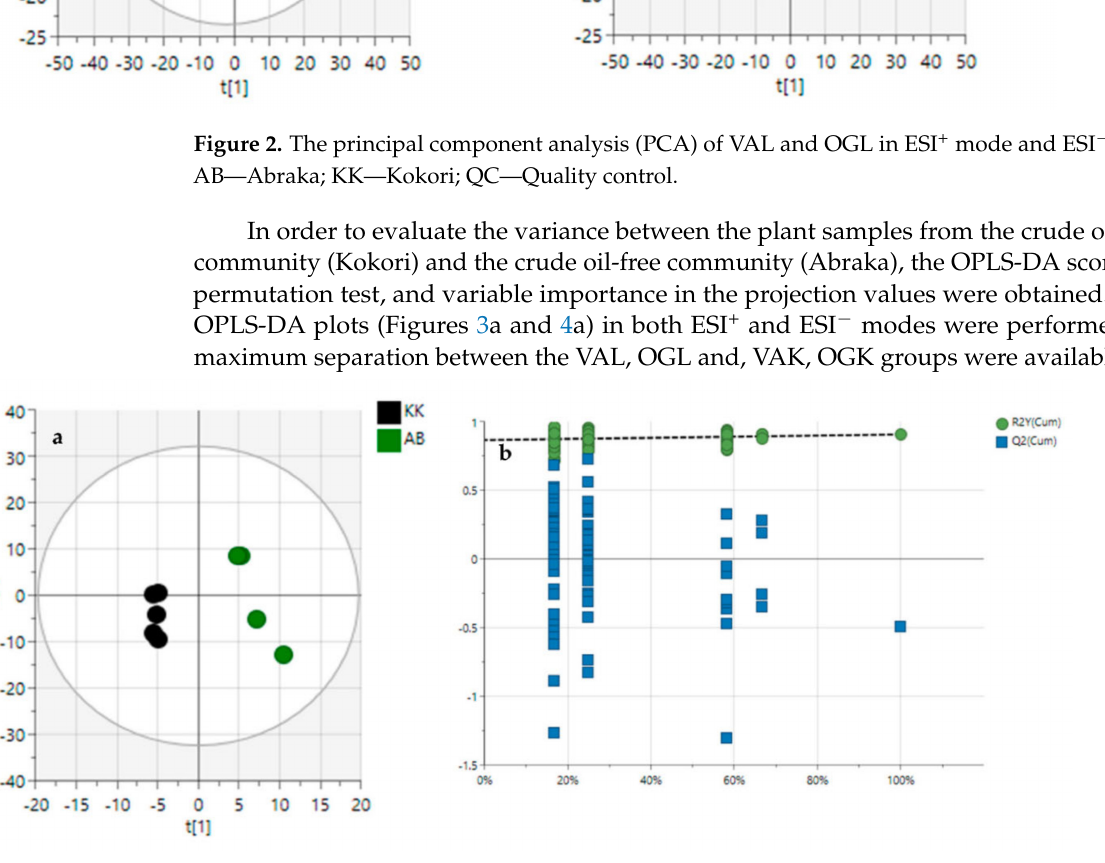
Figure 3. Orthogonal partial least squares discriminant analysis (OPLS-DA) ( a ), permutation tests, ( b ) in ESI + mode. AB—Abraka;